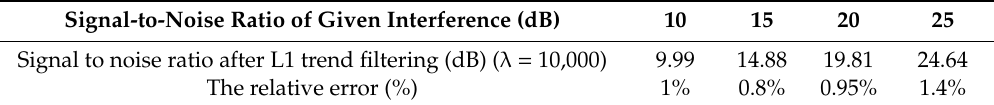
Table 1. The SNR obtained by L1 trend filtering under different noises. Signal-to-Noise Ratio of Given Interference (dB)